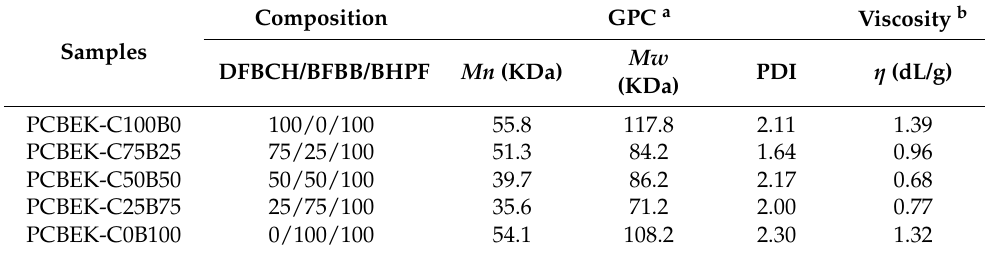
Table 1. Molecular weight test results of copolymer PCBEKs.